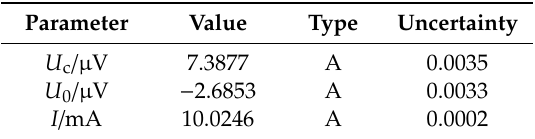
Table 1. Measured results and corresponding uncertainty. (standard resistance of 1 m Ω and load current of 10 mA).